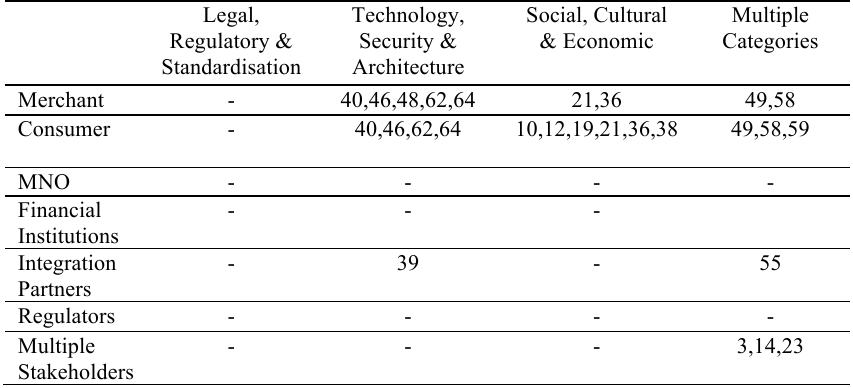
Table 3. Classification of the top 20 cited papers between 1999 and